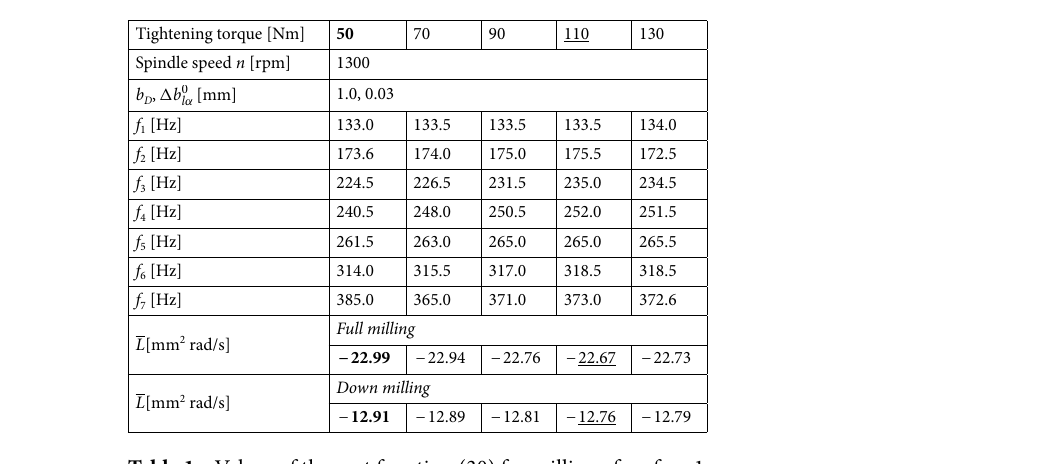
Table 1. Values of the cost function (30) for milling of surface